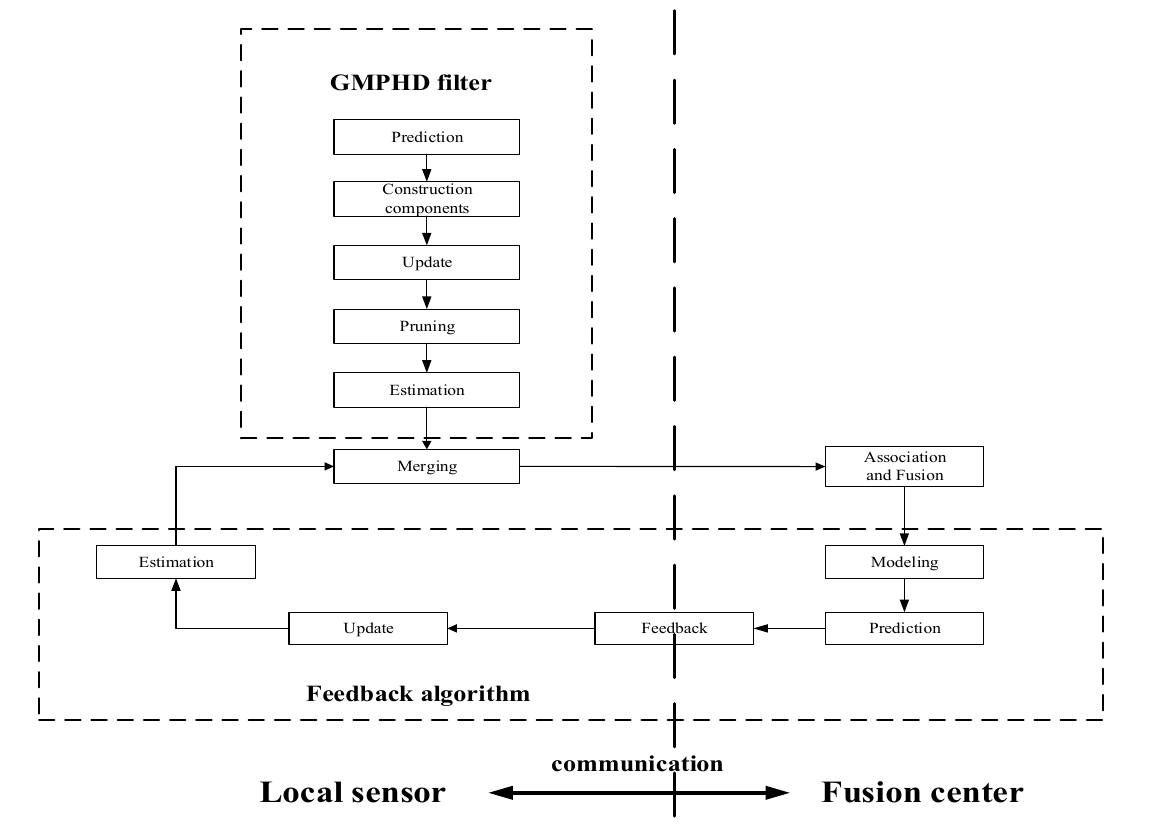
Figure 5. Structure of feedback algorithm.